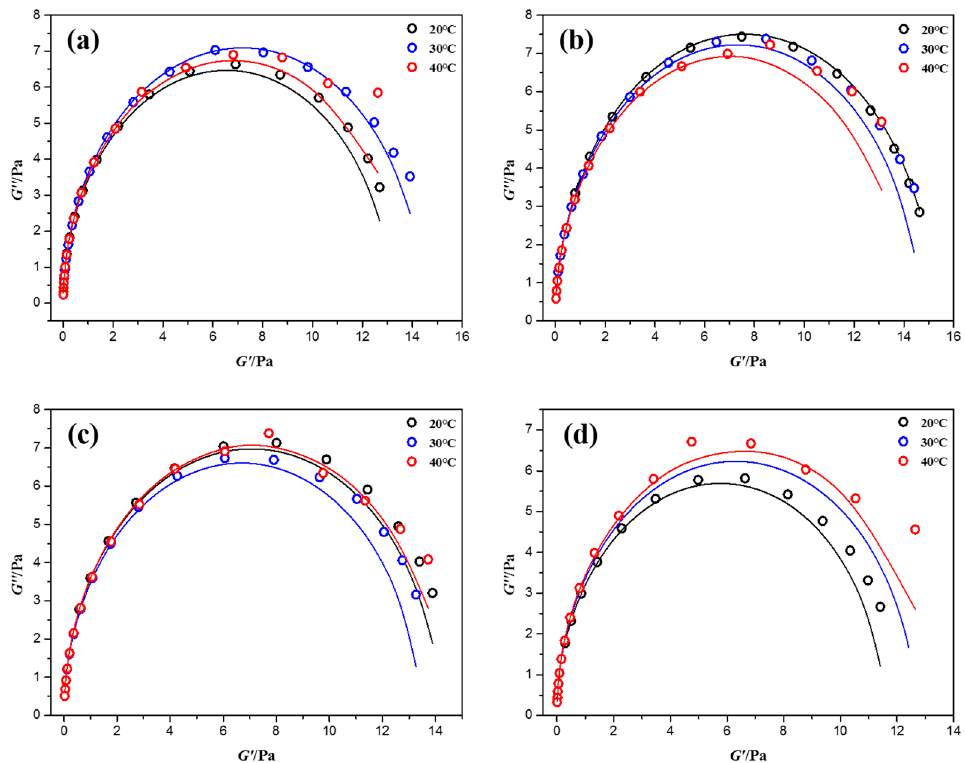
Figure 4. Cole-Cole plots for NEWMS at different temperatures as a function of the silica nanoparticle mass fraction ( a ) 0 wt % silica; ( b ) 0.1 wt % silica; ( c ) 0.3 wt % silica; and ( d ) 0.5 wt % silica.